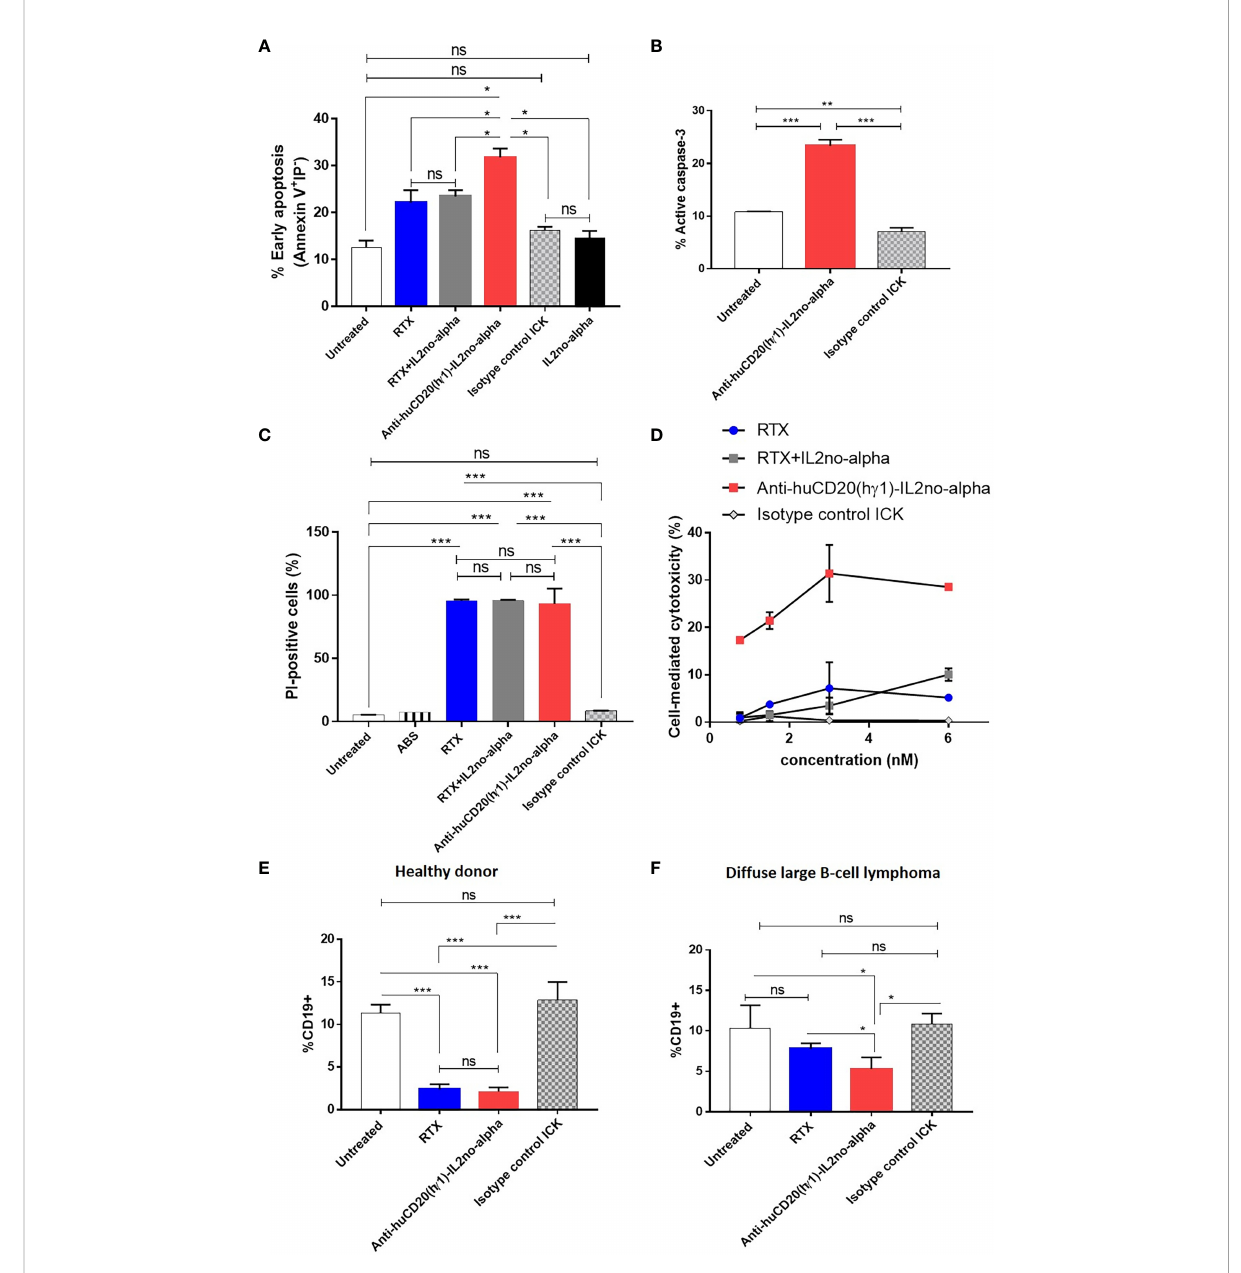
FIGURE 4 Anti-huCD20(h g 1)-IL2no-alpha ICK is effective in initiating apoptosis, CDC and ADCC. (A) Induction of apoptosis by anti-huCD20(h g 1)-IL2no- alpha. Human Burkitt ’ s lymphoma Ramos cells were incubated with 18nM of mAb or ICKs, or RTX (18nM) + mutein IL-2no-alpha (equimolar amount of cytokine) for 24 h at 37°C. Percentage of early apoptotic cells. (B) Late stage apoptosis was measured by activation of caspase 3. Ramos cells were incubated with IL2no alpha based ICKs (18 nM) for 48 h at 37°C. Percentage of cells with active-caspase 3 was determined by intracellular immuno fl uorescence staining (number of positive cells/number of total cells). MOPC-IL2noalpha was used as an isotype control ICK. Horizontal bars represent the mean ± SEM. (C) Induction of complement-dependent cytotoxicity (CDC). Human Burkitt ’ s lymphoma Ramos cells were treated with 6nM of RTX or ICKs for 2 h at 37°C. Human AB serum was used diluted 1:5. Cell lysis was determined by PI uptake. (D) Dose-dependent ADCC against Ramos cells. PBMC from one healthy human donor were used as source of effector cells and cocultured with Ramos cells at a 10:1 ratio, for 4 h at 37°C. Cytotoxicity was measured by an LDH-release assay and expressed in percentage. RTX and isotype control ICK were used as positive and negative controls, respectively. (E, F ) In vitro depletion of B cells from DLBCL patient. PBMC from a healthy donor ( E , control) and a DLBCL patient (F) were incubated in presence of 18nM of ICK, RTX or irrelevant ICK, for 24 h at 37°C. The percentage of B cells within the PBMC was measured by fl ow cytometry. Data correspond to three independent samples. Data represent the mean ± SEM. (Kruskal-Wallis, Dunn ’ s post hoc test, *P < 0.05; **P < 0.01; ***P < 0.001; ns, not signi fi